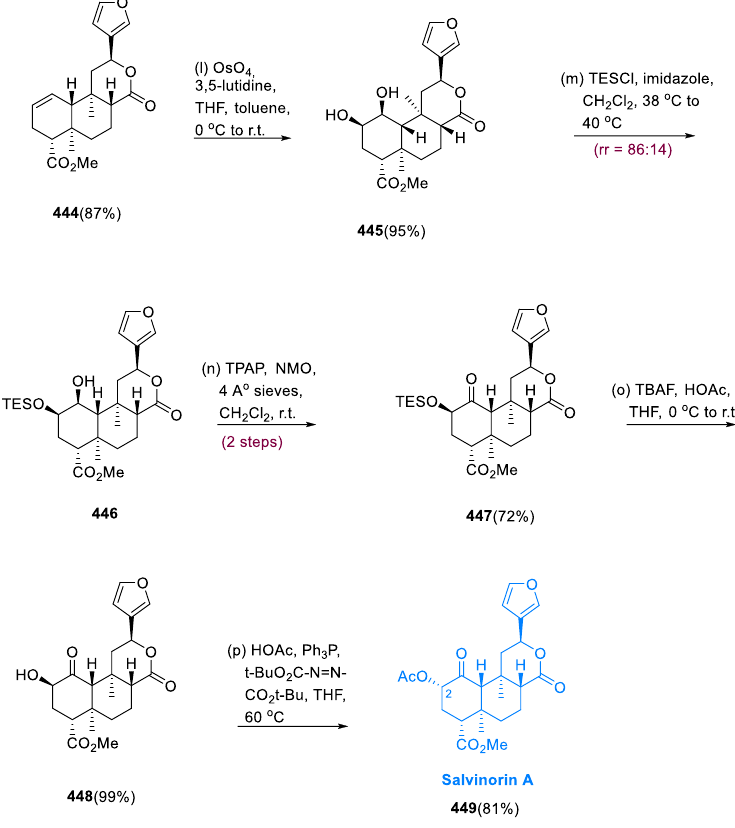
Scheme 27. Total synthesis of salvinorin